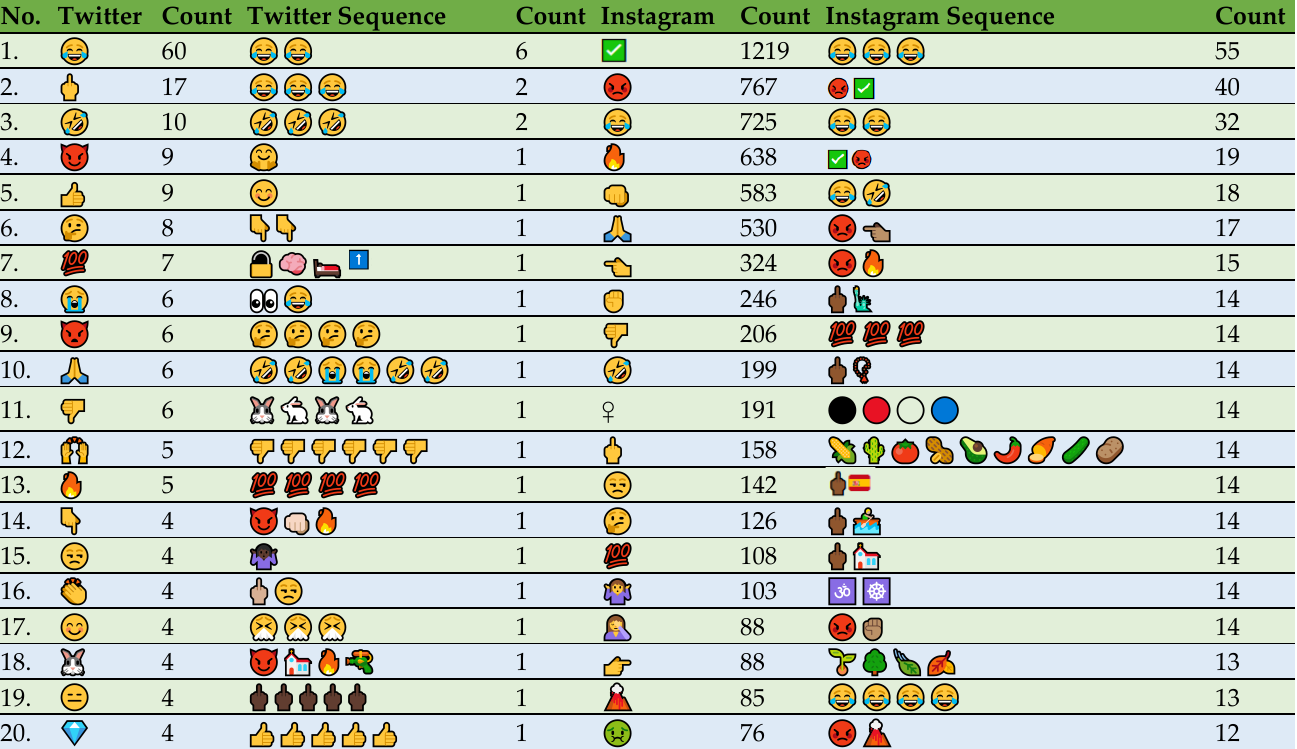
Table 5. The top sequence of emojis on Twitter and Instagram in relation to Christianity.